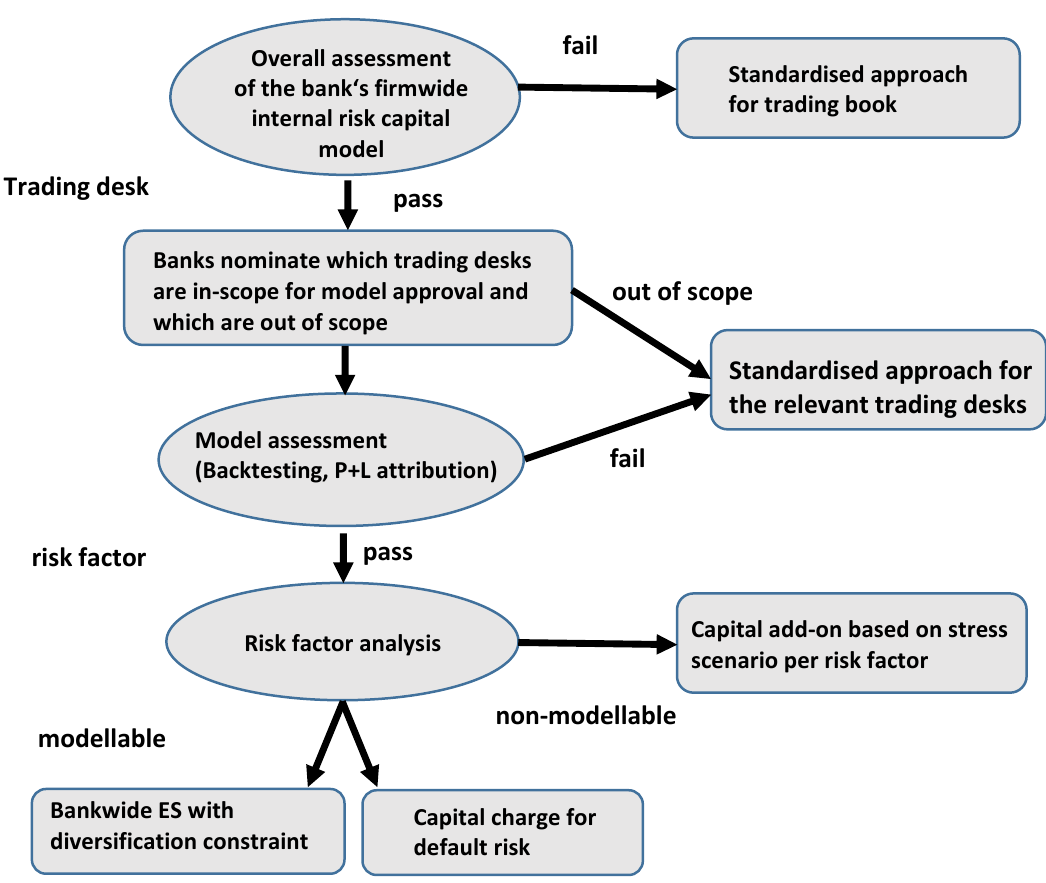
Figure 3. Determining eligibility of trading activities for the IMA